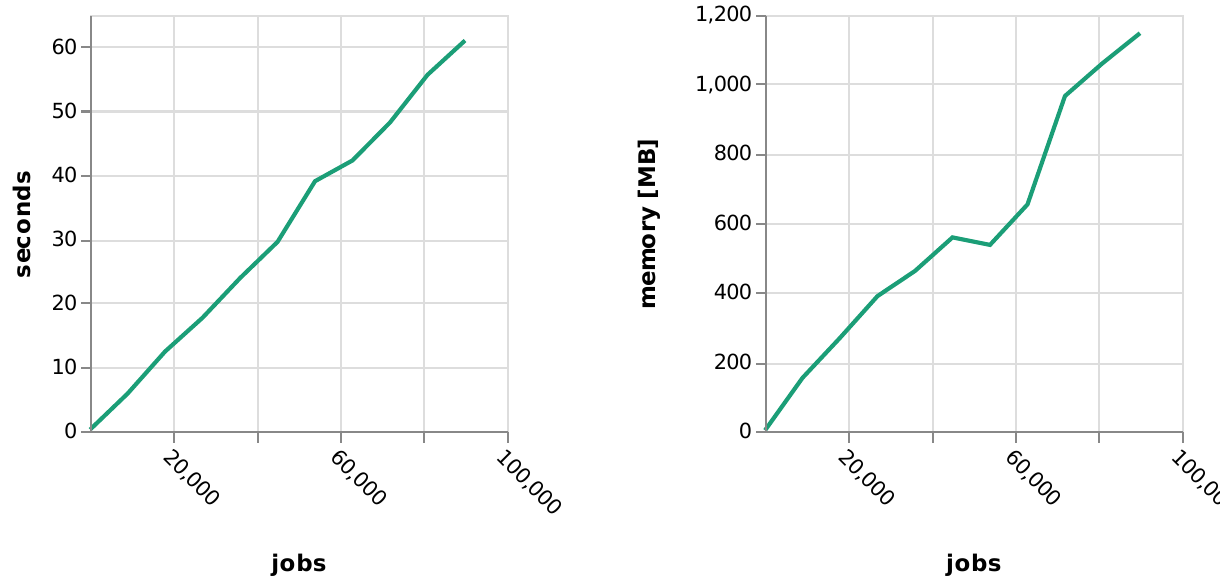
Figure 9. Runtime and memory usage of Snakemake while building the graph of jobs depending on the number of jobs in the workflow. The Snakemake workflow generating the results along with a self-contained Snakemake report that connects results and provenance information is available at